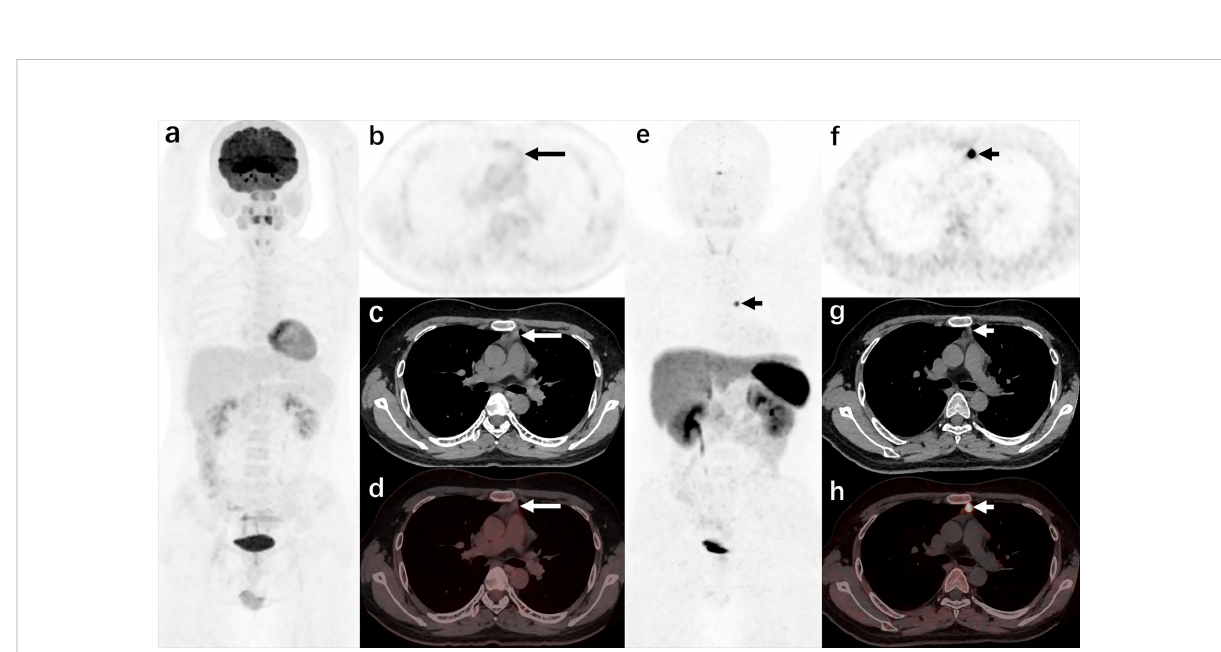
FIGURE 2 A 44-year-old man was admitted to the hospital due to “ a round face and weight gain for 2 years, and elevated blood pressure for 1 year ” (carcinoid of thymus, case 10 in the localization group) 18 F-FDG PET/CT [ (A) : MIP image, (B) : axial PET, (C) : axial CT, (D) : axial PET/CT fusion image] showed that there was no increase in radiotracer uptake in the anterior mediastinal nodule (long arrows); 68 Ga-DOTANOC PET/CT (E) : MIP image, (F) : axial PET, (G) : axial CT, (H) : axial PET/CT fusion image] showed increased radiotracer uptake of the anterior mediastinal nodule.